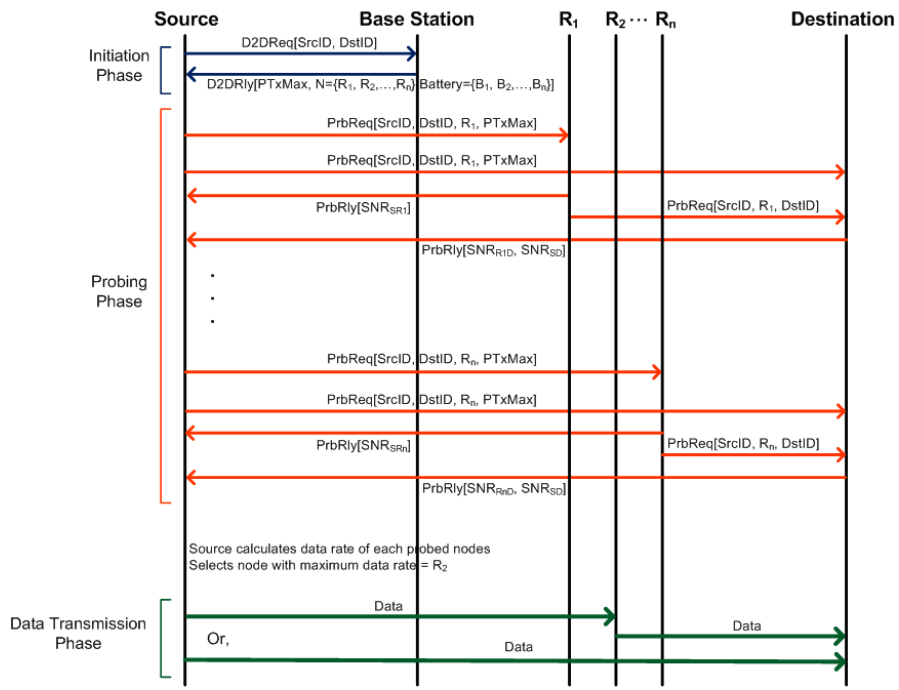
Figure 2. Probing for relay